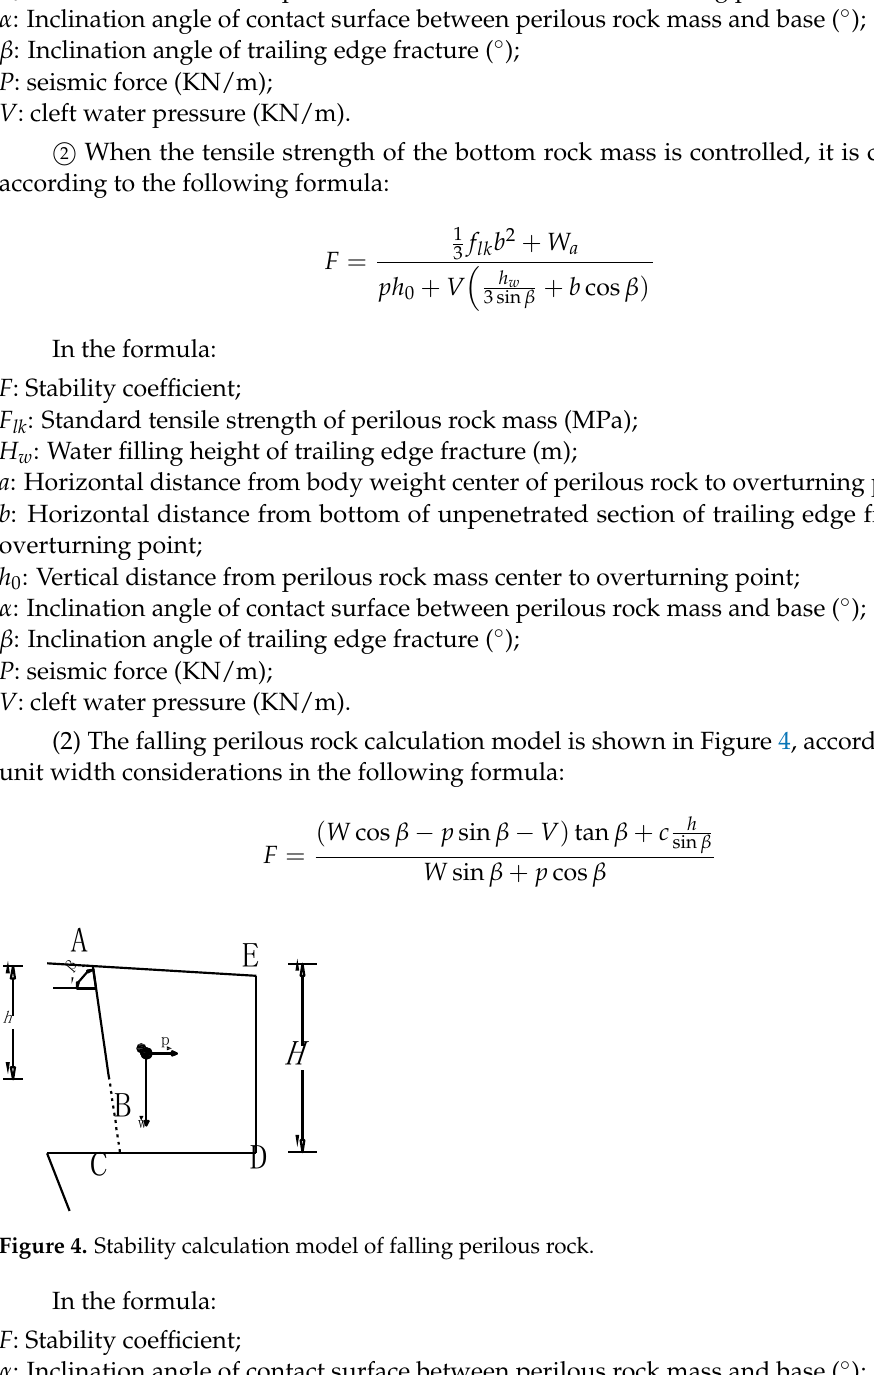
Table 3. Criteria for classification of the stability state of a perilous rock mass.